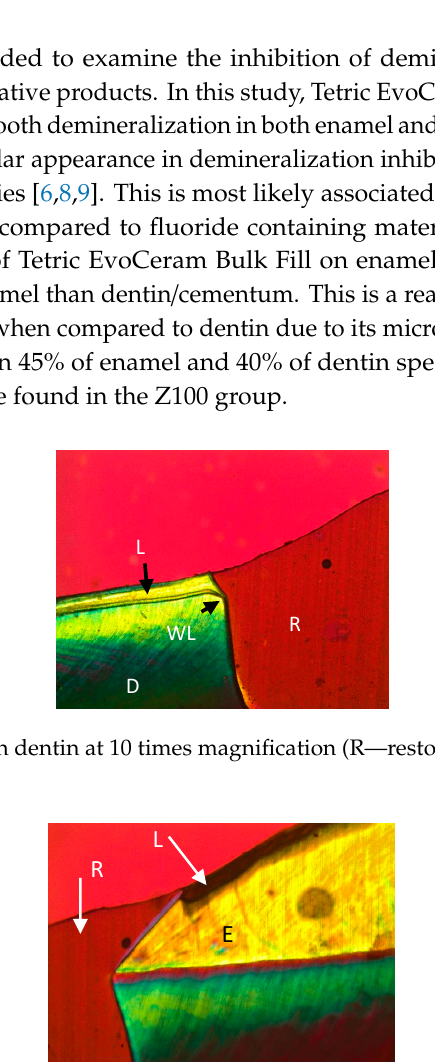
Figure 3. Tetric Evoceram Bulk Fill in dentin at 10 times magnification (R—restoration, L—lesion, IZ—inhibition zone). Figure 4. Tetric Evoceram Bulk Fill in enamel at 10 times magnification (E—enamel, L—lesion, R— restoration).